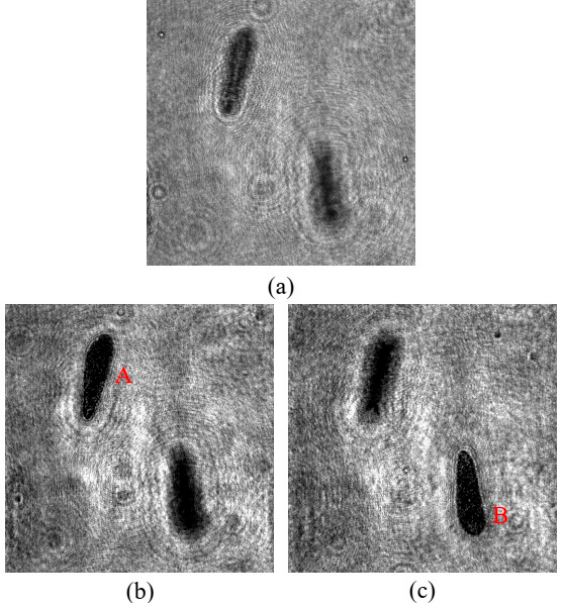
Figure 4. Reconstructed holograms ( a ), original hologram ( b ), and ( c ) reconstructed holograms with different focus distances.